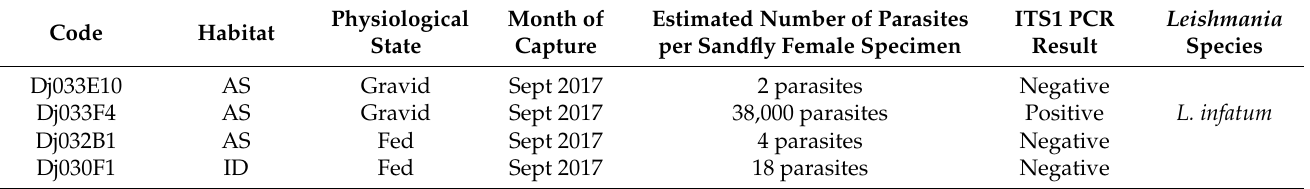
Table 5. Parasitic load, ITS1 PCR results, and Leishmania species identification of infected